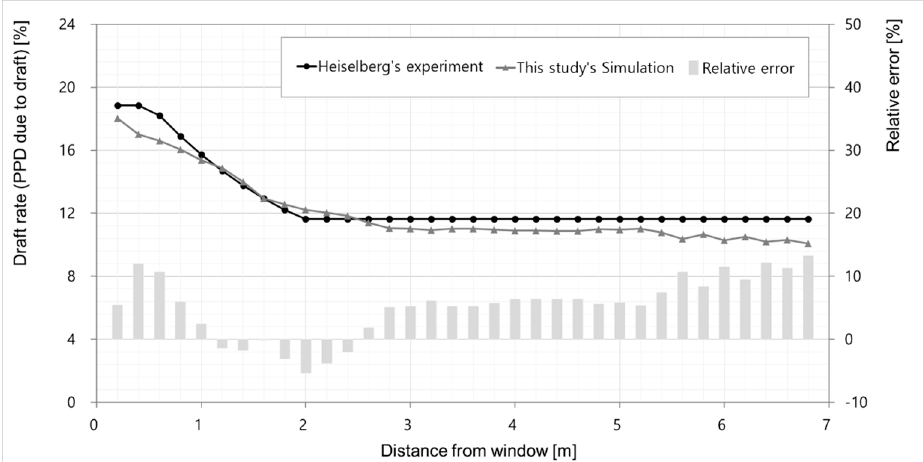
Figure 7. Result of draft rate comparison.